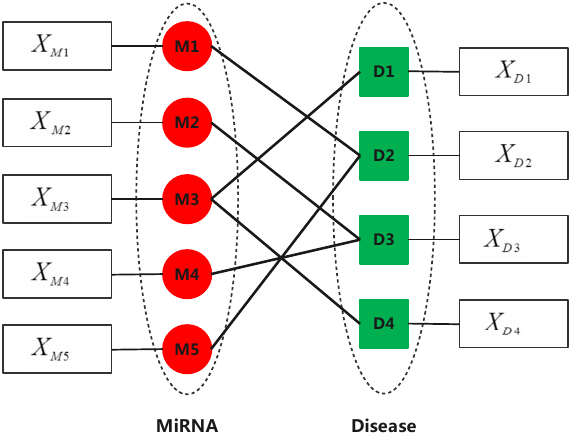
Figure 3. A single layer in our attributed multi-layer miRNA-disease heterogeneous network, where X Mi and X Dj represent the feature vector of miRNA Mi and that of disease Dj ,